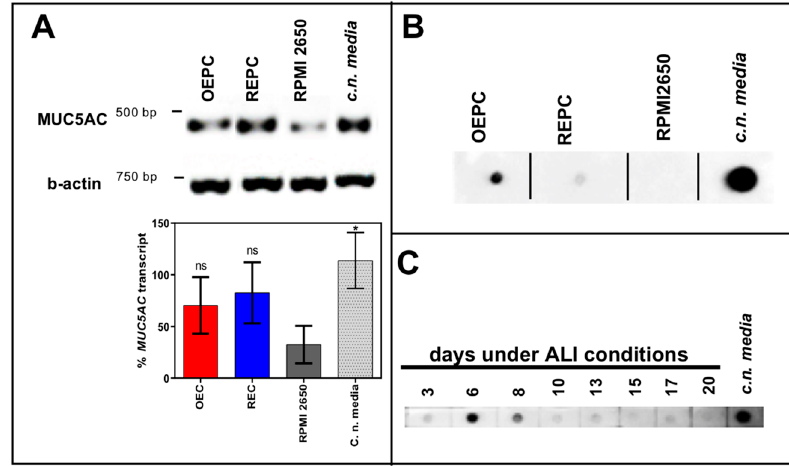
Figure 4. Mucin MUC5AC expression and immunoreactivity in primary cells of the nasal cavity. ( A ) Transcription analysis (RT-PCR) of MUC5AC gene in olfactory epithelial primary cells (OEPC), respiratory epithelial primary cells (REPC), tumour cell line RPMI 2650 and the concha nasalis media